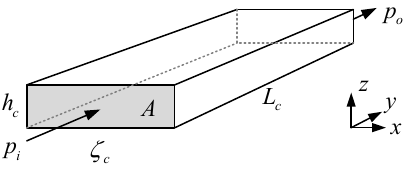
Figure 11. Hypothetical rectangular leakage channel.